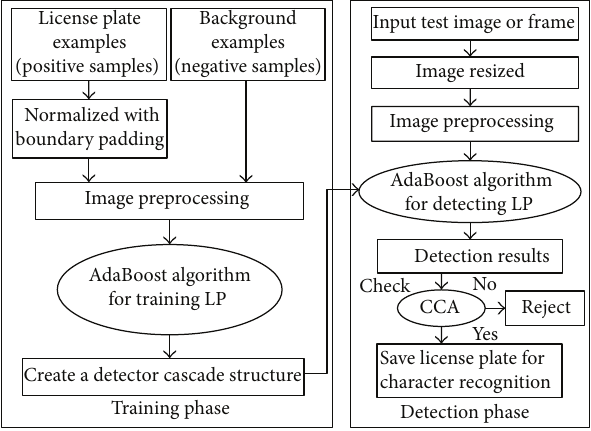
Figure 3: Framework of the proposed LPD system using cascade AdaBoost.